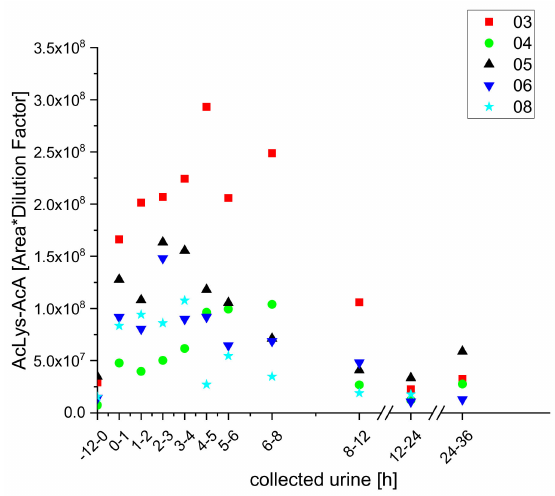
Figure 12. Excretion kinetics of AcLys-AcA: UPLC-qToF-MS / MS measurements of contents in samples of urine from participants three, four, five, six, and eight at indicated times after co ff ee consumption (h).